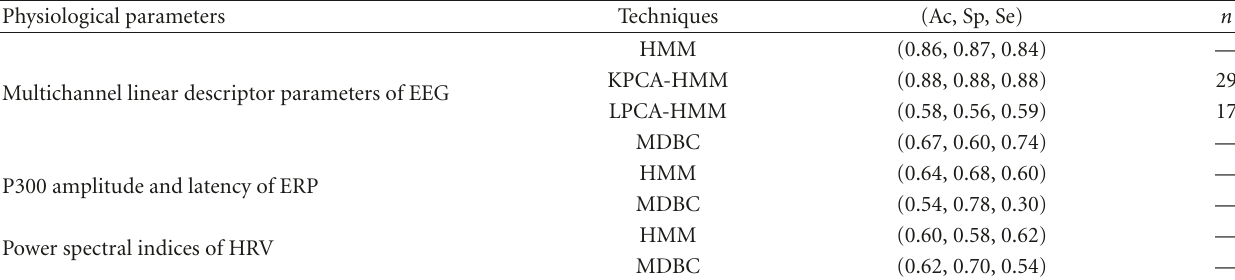
Table 2: The comparison of the performances as di ff erent physiological parameters are used.